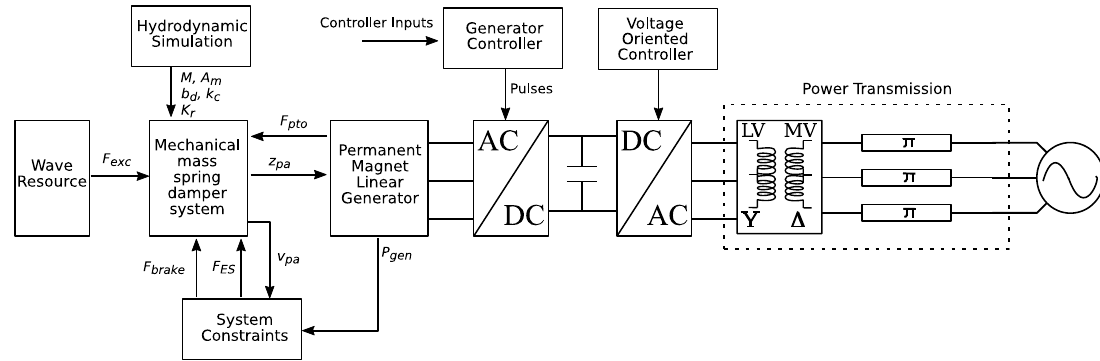
Figure 2. Wave-to-wire WEC model developed primarily in MATLAB/Simulink. The hydrodynamic simulations were performed in NEMOH. The model incorporates a DD All-Electric PTO system, system constraints, power transmission and grid connection.